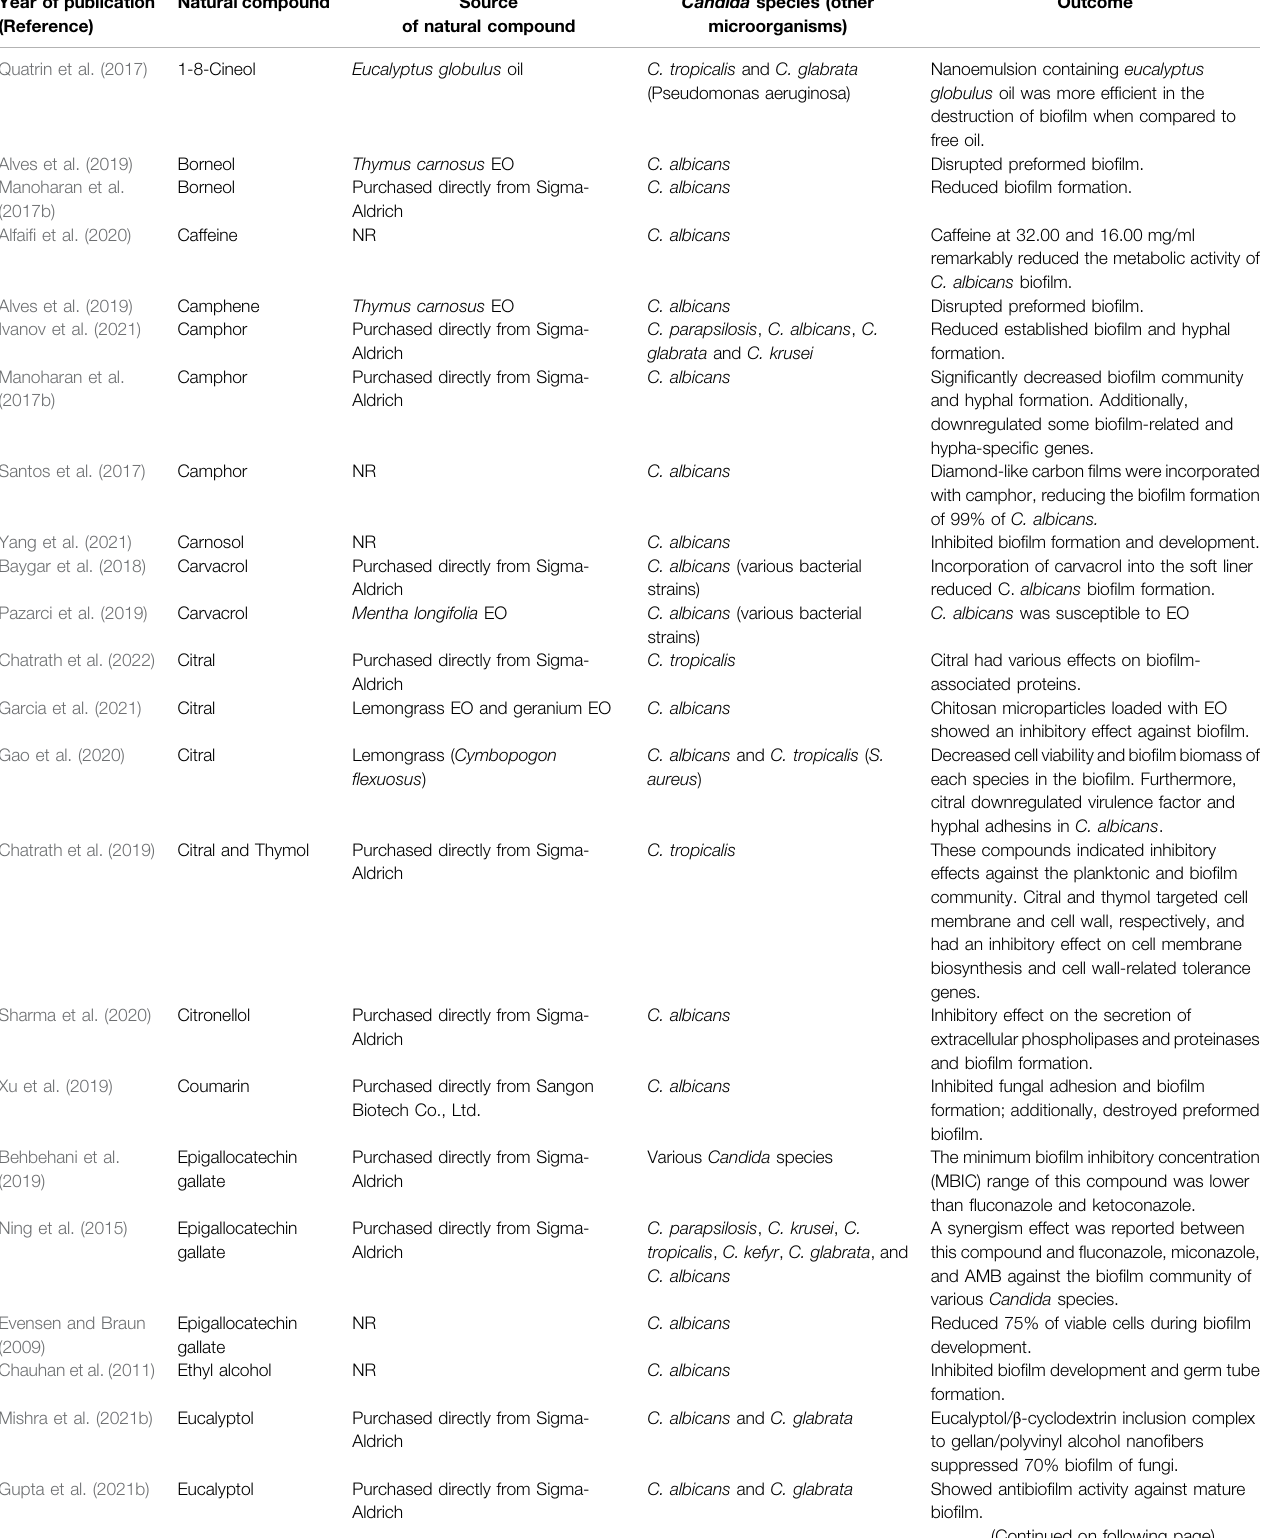
TABLE2| Thestudiesthathaveemployedvariousnaturalcompoundsforinhibitionanddegradationofthe Candida bio fi lm.Naturalcompoundsthatarethemainingredient of their-associated plants are reported